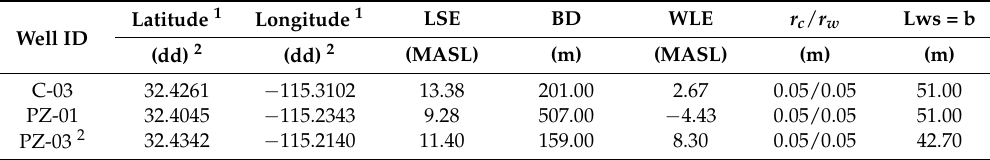
Figure 2. ( a ) Records of the water level and barometric pressure time series, expressed as the centimeters of a water column equivalent and hectopascals, respectively, from 23 May to 14 August 2007. The water level, referenced to an arbitrary elevation and barometric pressure datum, is offset 950 centimeters below sea level; ( b ) The calculated areal strain associated with the theoretical gravitational potential. Table 1. Summary of some basic information about the three monitoring wells. Explanation: Well-Identifier, Well-ID; Land Surface Elevation, LSE (meters above sea level, MASL); Borehole Depth, BD (meters); Water Level Elevation, WLE (MASL); radius of the well casing r c (meters); radius of the well screened r w (meters); and Length of well screened, Lws